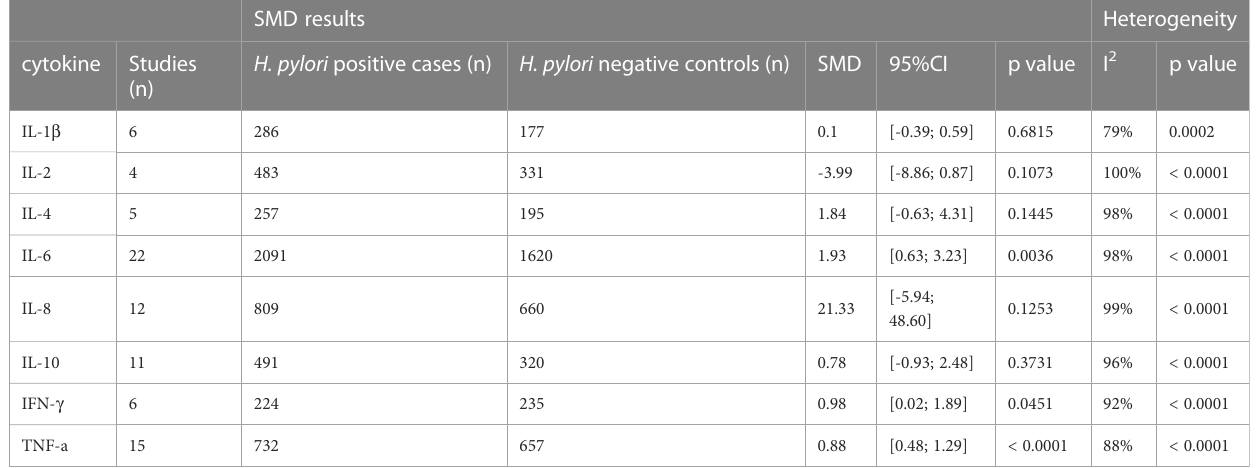
TABLE 1 Standardized mean differences of cytokine levels in serum upon H. pylori infection.